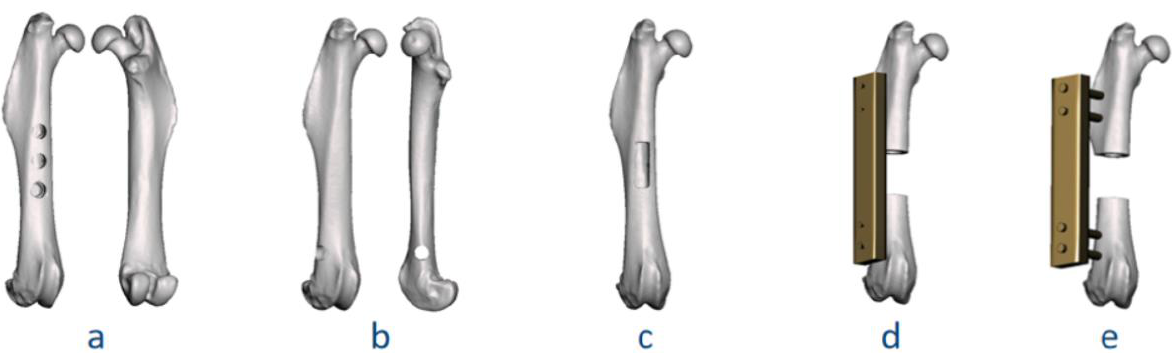
Figure 7. Virtual surgeries for application of the classification system. Coding results: ( a ) II.a-BT.u-